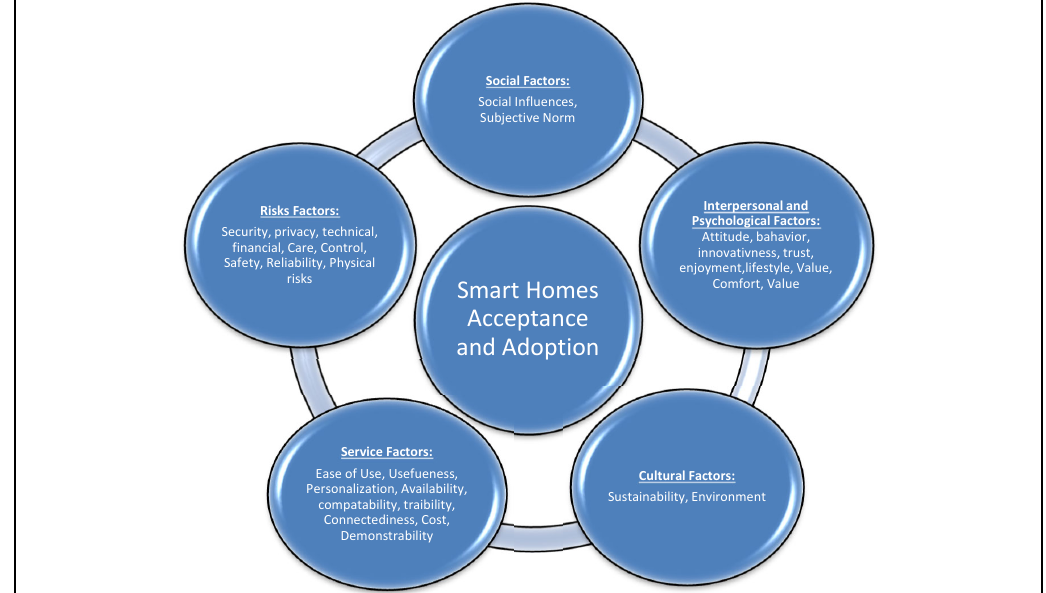
Fig. 6. Categories of factors of Smart Homes Acceptance and